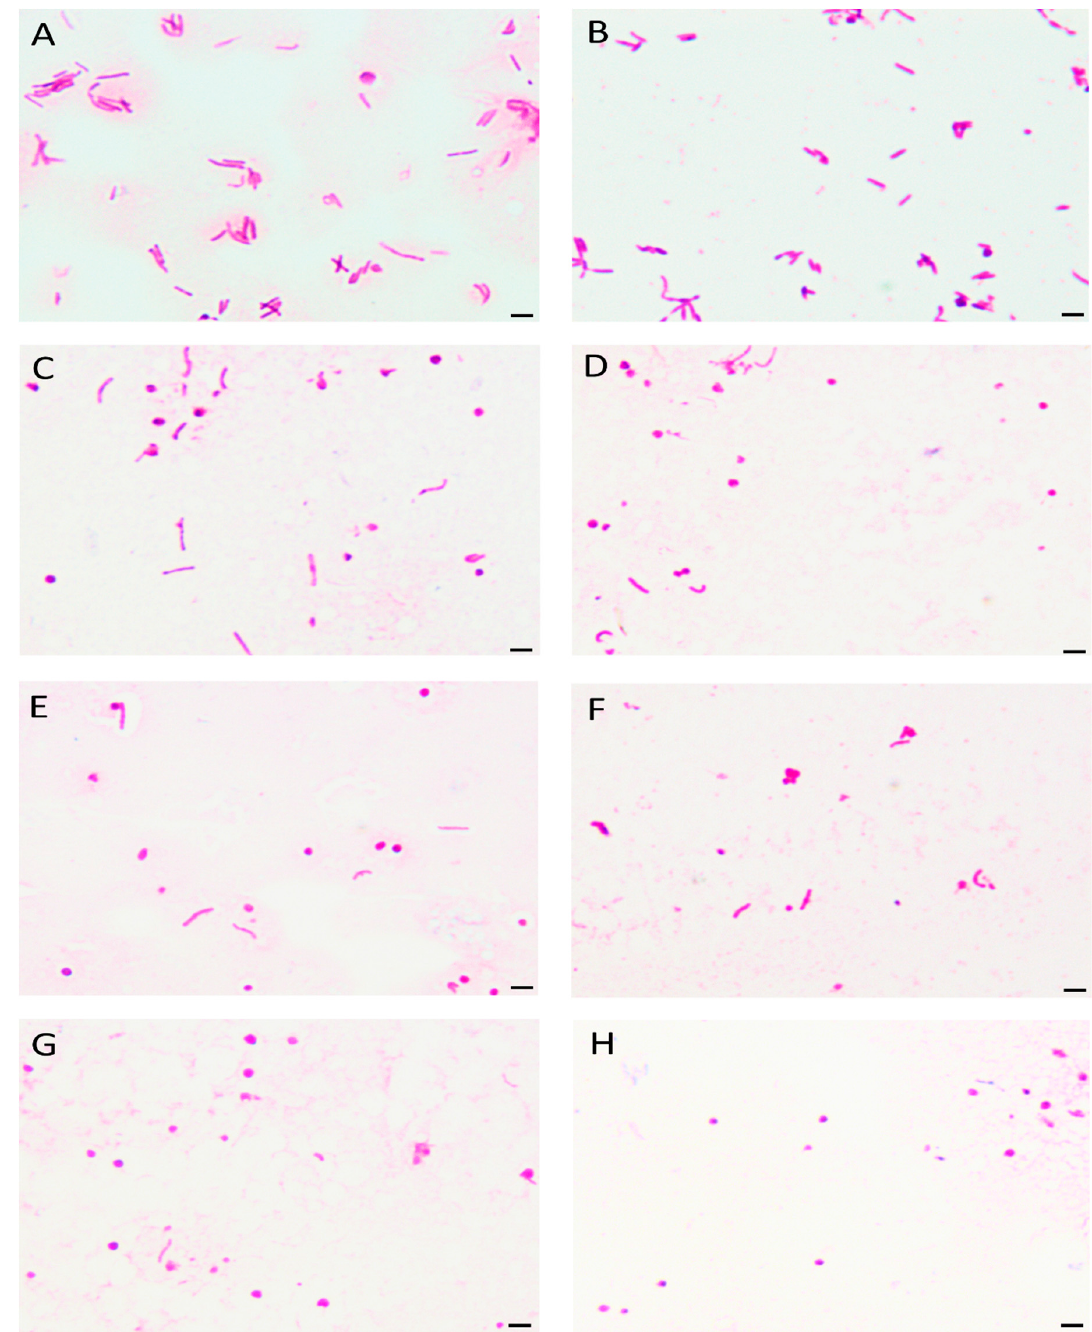
Figure 3. The light microscopy of H. pylori cells during the incubation with 3-Bromopyruvate (3-BP): The representative microscopic images of H. pylori cells during the incubation with the MIC of 3-BP after ( A ) 0 h, ( B ) 1 h, ( C ) 2 h, ( D ) 4 h, ( E ) 6 h, ( F ) 8 h, and ( G ) 24 h show a time-dependent decrease in the number of spiral forms with an inversely proportional increase in the number of coccoid forms. The negative control consisted of bacterial cells ( H ) after a 1 h treatment with 70% ethanol. The scale bar in the light microscopy is 2 μ m.